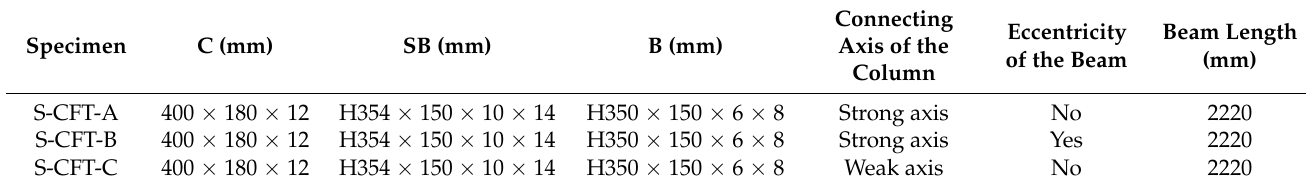
Figure 7. Dimensions of the test specimens (unit: mm): ( a ) Dimensions of the short beam; ( b ) Di- aphragm dimensions of specimen S–CFT–A; ( c ) Diaphragm dimensions of specimen S–CFT–B and C; ( d ) Profile of specimen S–CFT–A and B; ( e ) Profile of specimen S–CFT–C. Table 1. Parameters of the test specimens.